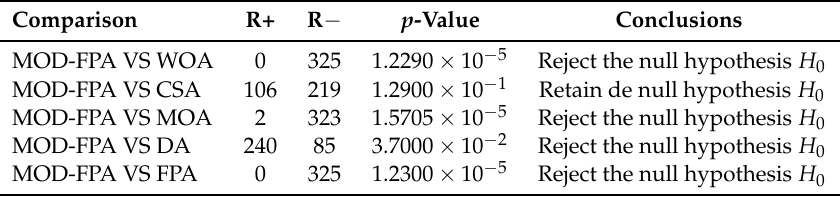
Table 15. Wilcoxon signed rank test results with a level of significance ∝ = 0.05.